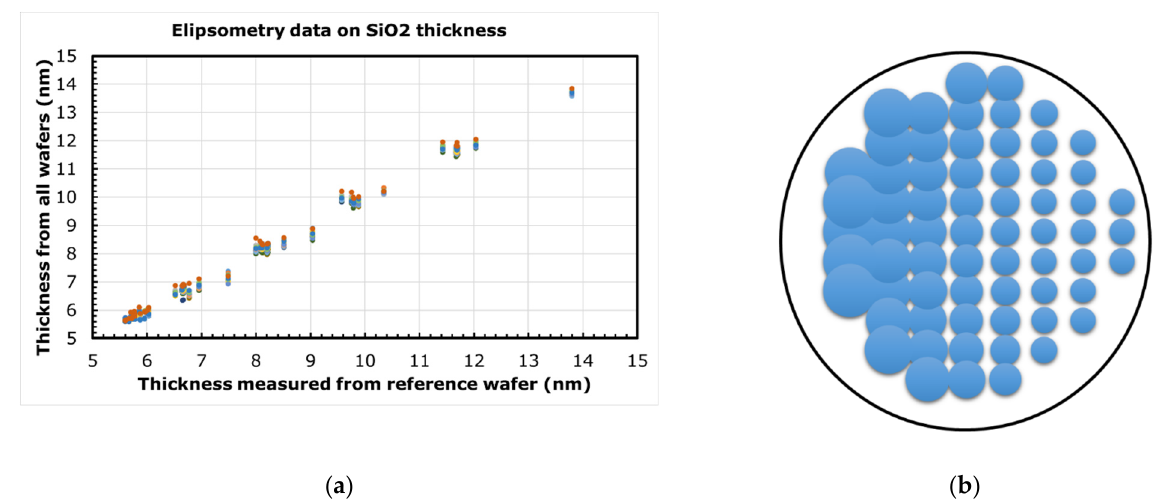
Figure 4. ( a ) Thickness of SiO 2 , after slant etch and plasma enhanced atomic layer deposition (PEALD) oxide deposition, measured across multiple wafers using ellipsometry; ( b ) Equivalent oxide thickness (EOT) computed from capacitance– voltage (CV) measurement. Bubble size represents EOT magnitude.